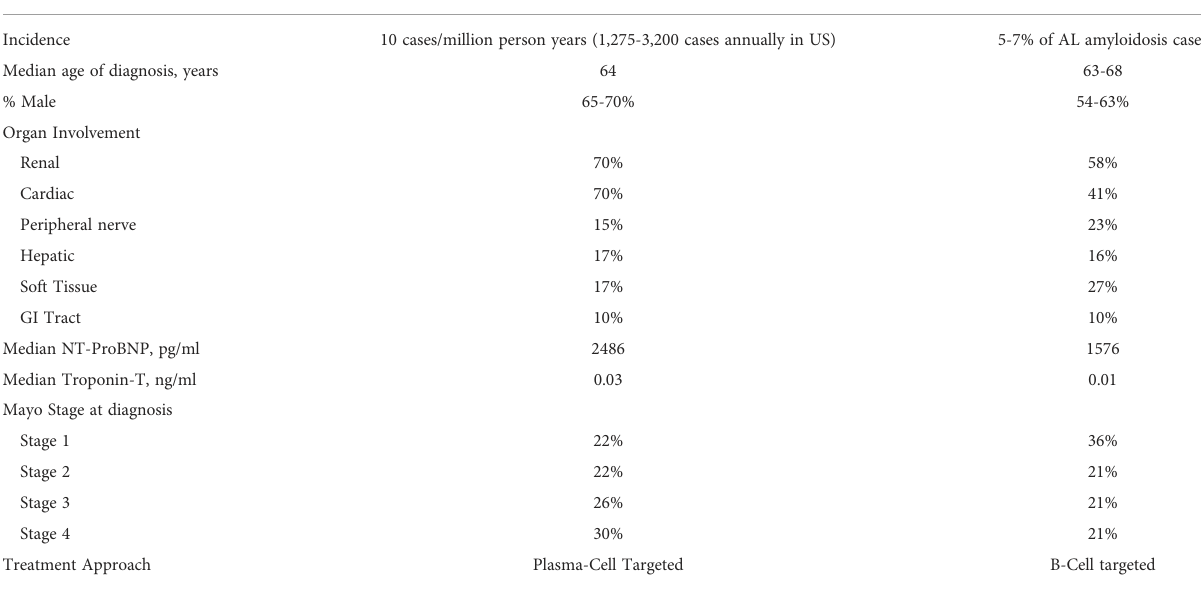
TABLE 1 Comparison of AL Amyloidosis and IgM AL amyloidosis (2, 5,